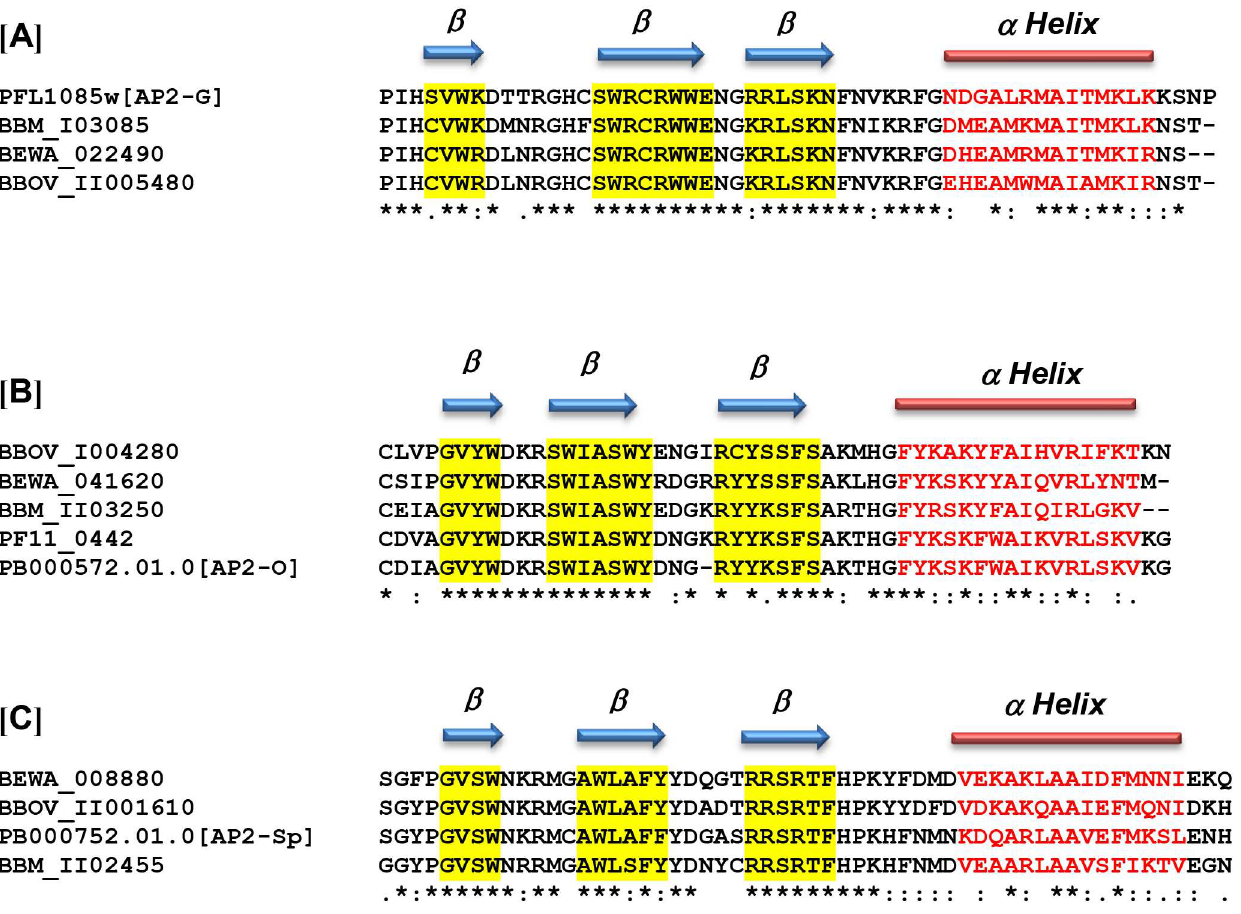
Fig 4. Alignments among B. bovis , B . microti , T equi and functionally defined Plasmodium Ap2 domains. Alignmentsof: ( A) B . bovis BBOV_II005480, B . microti BBM_I03085, and T . equi BEWA_022490 with P . berghei PB000752.01.0, a domain involvedin the development of sexual-stageforms in Plasmodium (AP2-G). (B) AP2 domain of the protein encodedby the B . bovis AP2 gene BBOV_I004280, B . microti BBM_II03250, and T . equi BEWA_041620 with putative orthologues in P . berghei (PB00572.01) and P . falciparum , (PF11_0442). Both Plasmodium AP2 proteins are requiredfor the development of ookinetes, and known as AP2-O. ( C) B . bovis BBOV_II001610, B . microti BBM_II02455, and T . equi BEWA_008880 with P . berghei PB000752.01.0, a domain involvedin the development of sporozoites (AP2-Sp). Predicted secondary structures for the domains of interest are depicted at the top of each of the